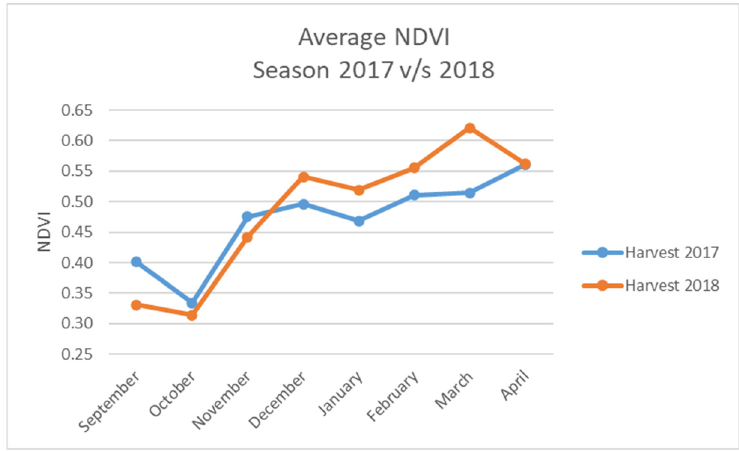
Figure 6. Average NDVI in both plantations in 2017 and 2018